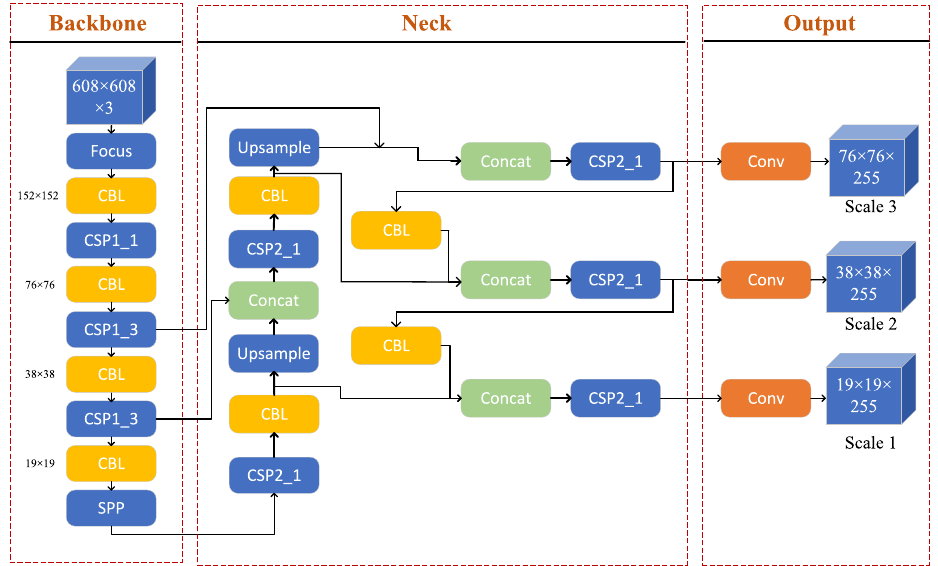
Figure 1. The architecture of the YOLOv5 method. The network consists of three main parts: backbone, neck, and output. Backbone part focuses on extracting feature information from input images, neck part fuses the extracted feature information and generates three scales of feature maps, and the output part detects the objects from these generated feature